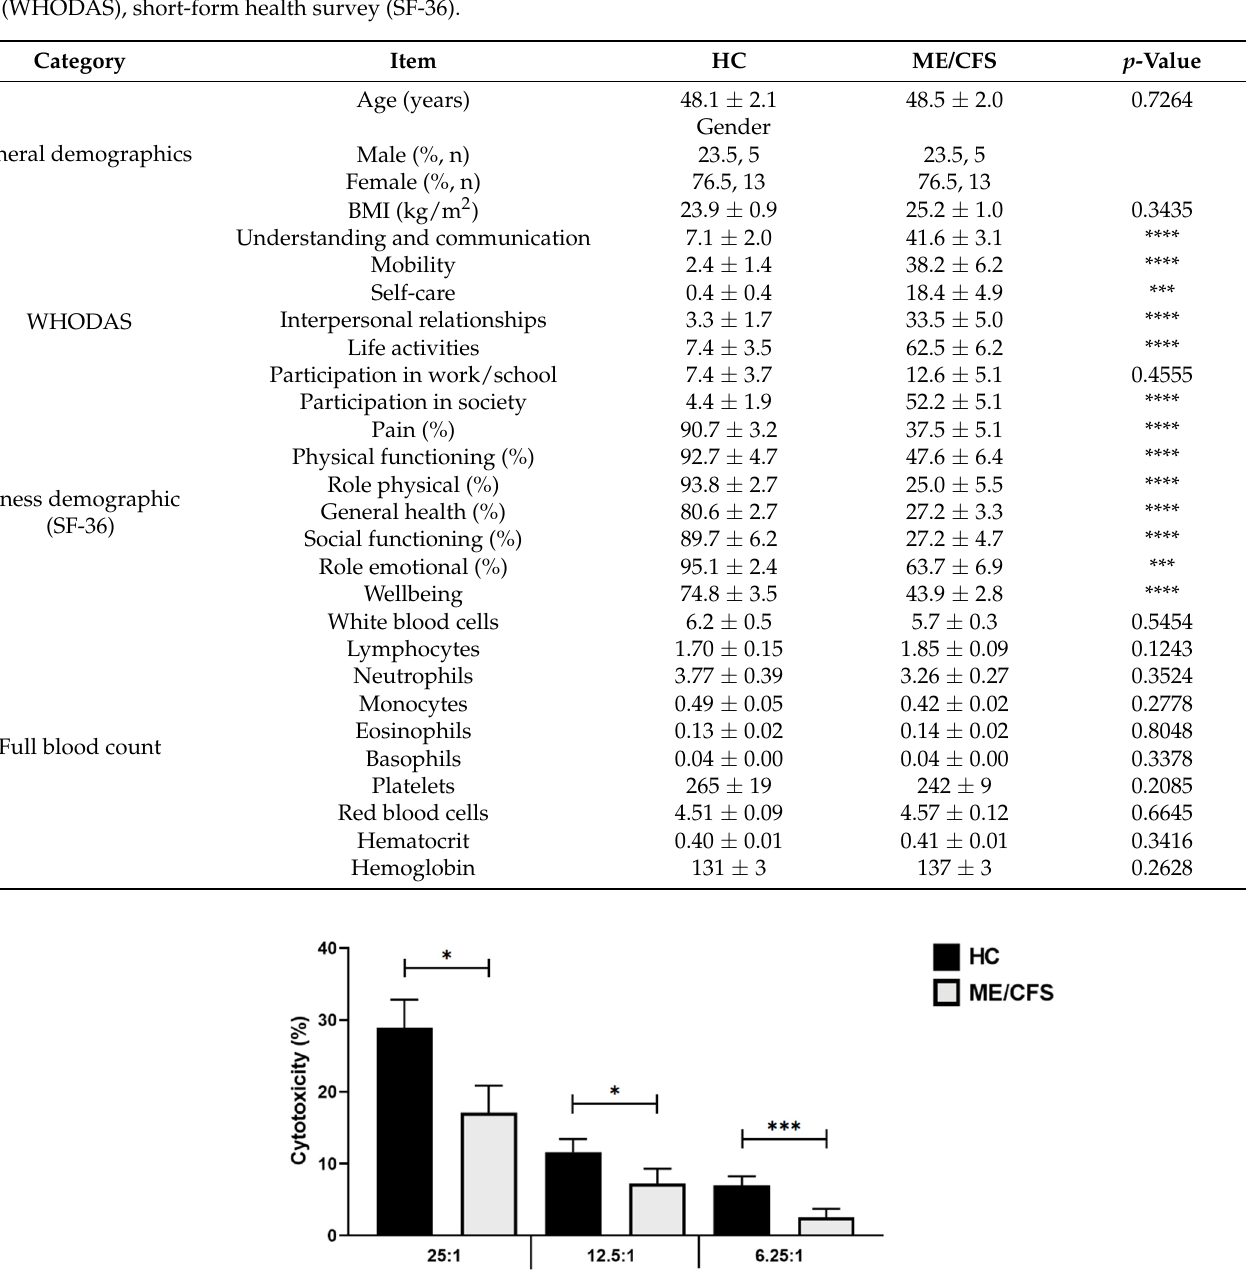
Figure 1. Baseline NK cell cytotoxicity; n = 17 for HC and n = 17 for ME/CFS. A significantly lower NKCCA was observed in ME/CFS patients compared with HCs at baseline for each effector to target ratio. Data are represented as the mean ± SEM as determined by independent Mann-Whitney U tests. * p < 0.05, *** p < 0.001. Abbreviations: healthy control (HC), myelogenous leukemia target cell